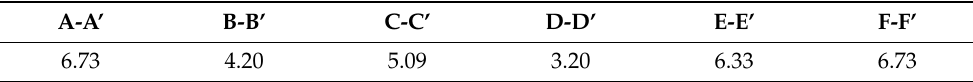
Figure 2. Layout of the proposed UWB phase inverter. Dimensions: w ms = 10, w cpw = 10, w slot = 6, l ms1 = 80, d m = 20, l cpw = 90, l slot = 40, d r = 60, d via = 8, l ms2 = 64, λ g(slot)/4 = 100, λ g(ML)/4 = 80 (units: mil), θ 1 = 60°, θ 2 = 45°. Table 1. Effective dielectric constants along the